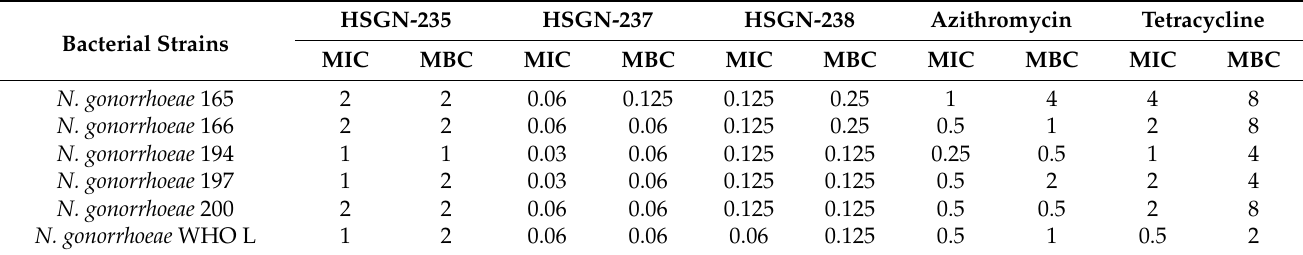
N. gonorrhoeae strains. Table 2. MICs and MBCs ( µ g/mL) of HSGN-235 , -237, and -238 against N. gonorrhoeae clinical isolates. The experiment was repeated three independent times and the same MIC values were obtained. Bacterial